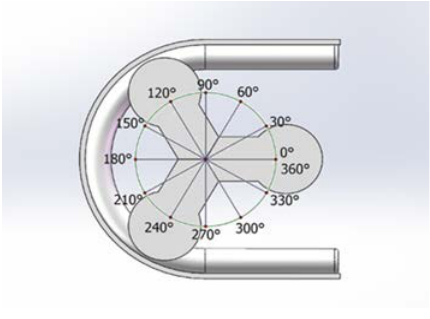
Figure 11. Rotation angle of roller.